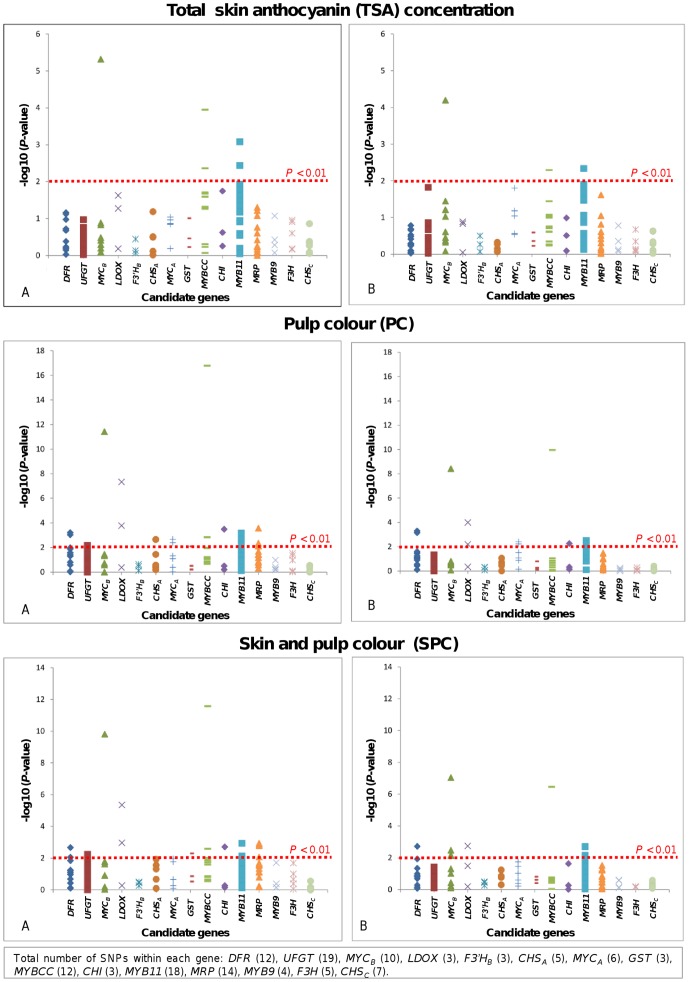
Results of association test of TSA concentration, PC and SPC.Graphs A and B show results for tests of association based on models A and B, respectively. The y axis shows −log10 (P-values). The different genes studied are shown along x axis. The total number of SNPs within each gene is indicated at the bottom.